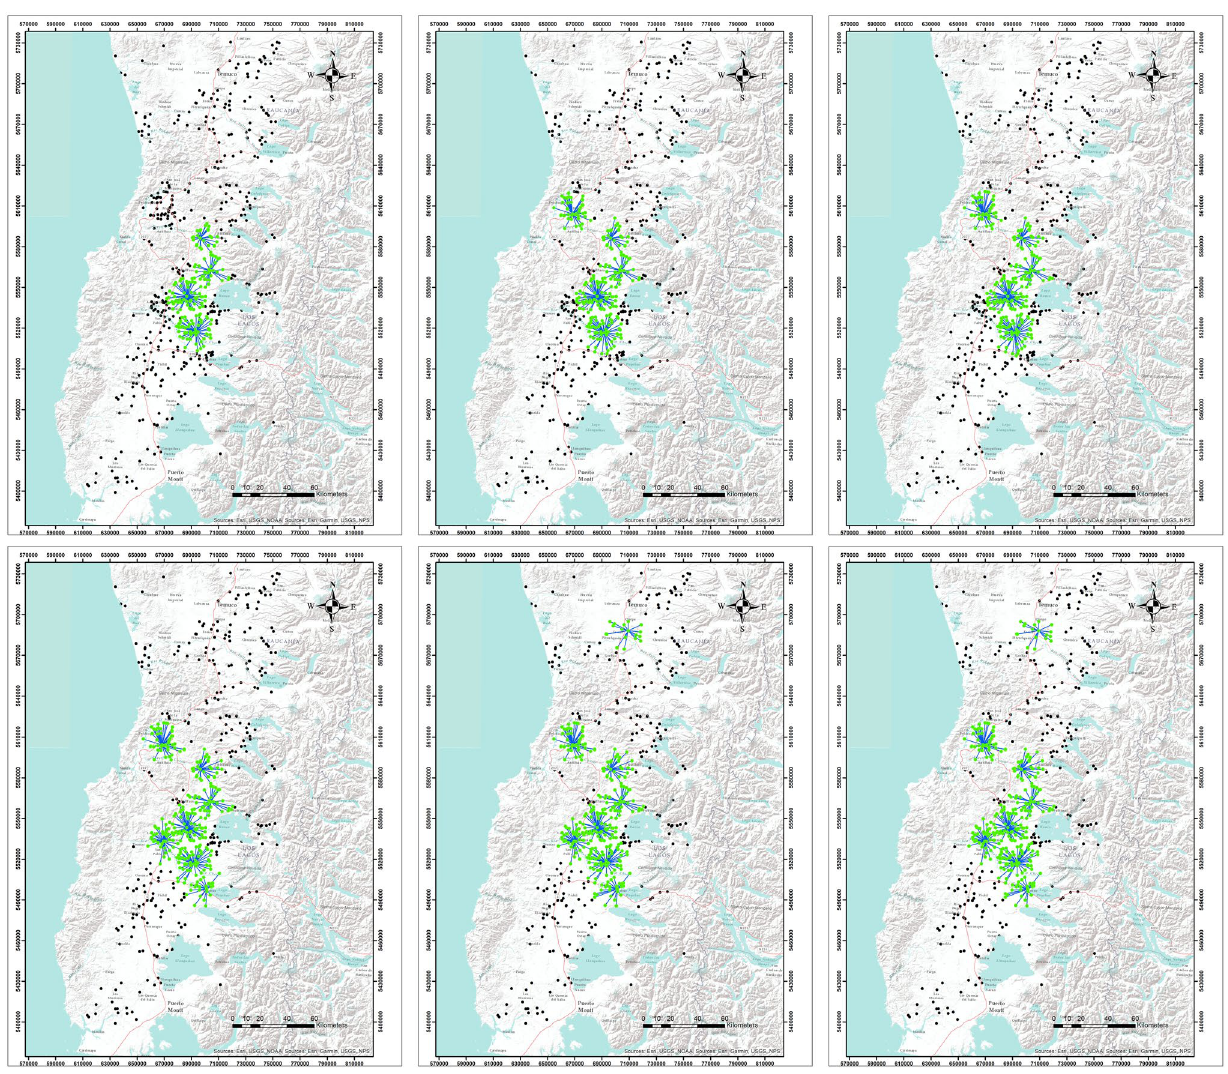
Fig. 10 Location of the configurations of the best combination found, with 80% biomass availability scenario, transport cost of 0.3 USD/tkm, and energy price of 90, 92, 94, 96, 98 and 100 USD/MWh, in order of